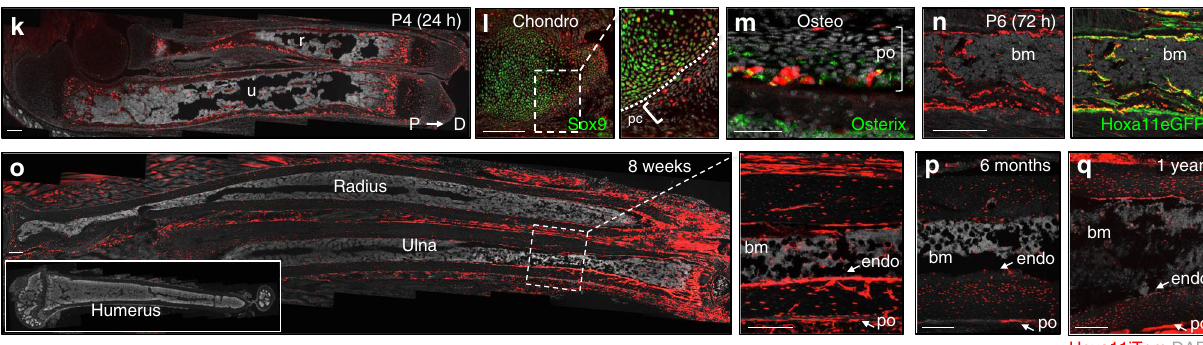
Fig. 3 Hoxa11 -lineage contributes to the zeugopod skeleton throughout life. a Schematic of Hoxa11-CreER T2 allele. Exon 1 of Hoxa11 was replaced with CreER T2 followed by a rabbit β -globin poly-adenylation (PA) stop sequence (see “ Methods ” section). Endogenous sequence in blue, edited sequence in red, start site marked by ‘ ATG ’ . b – j Pregnant females were given tamoxifen at E13.5 and resulting Hoxa11eGFP;Hoxa11-CreER T2 ;ROSA-tdTomato animals were examined at indicated ages. Shown are complete limb ( b , e , h ), distal radius (r) and ulna (u) ( f , g ) or distal diaphysis region of tibia ( i , j ). c Expression of Hoxa11iTom and chondrocyte marker, Sox9 (green) at E14.5, dashed white lines demarcates anlage and bracket marks perichondrium. d Expression of Hoxa11iTom and osteoblast marker, Osterix (green) at E14.5, bracket marks periosteum. f Co-expression of Hoxa11eGFP and Hoxa11iTom. g Inset shows Hoxa11 -lineage marked bone marrow stromal cells (white dashed box). k – q P3 pups received tamoxifen and Hoxa11eGFP;Hoxa11-CreER T2 ; ROSA-tdTomato mice were examined at indicated ages. Shown are complete limb ( k , o ), mid-diaphysis ulna ( n ), or distal region of tibia ( p , q ). l Co-expression of Hoxa11iTom and chondrocyte marker, Sox9 (green) in the growth plate at P4 Boxed region enlarged to right, dashed white line demarcates perichondrial border. m Co- expression of Hoxa11iTom and osteoblast marker, Osterix (green) in the periosteum (bracket) at P4. b , n Right panel shows co-expression of Hoxa11iTom with Hoxa11eGFP. h , o Inset shows complete humerus. Dashed white box shown magni fi ed to right; view of mid-diaphysis ulna. All images shown with distal end of bone to right. In all images, red: Hoxa11 -lineage marked cells (Hoxa11iTom), green: Hoxa11eGFP-expressing cells (unless otherwise noted), gray: DAPI. Bone marrow: bm, perichondrium: pc, periosteum: po, endosteum: endo. Scale bars: ( c , n ) 100 μ m, ( d ) 50 μ m. All other scale bars = 200 μ